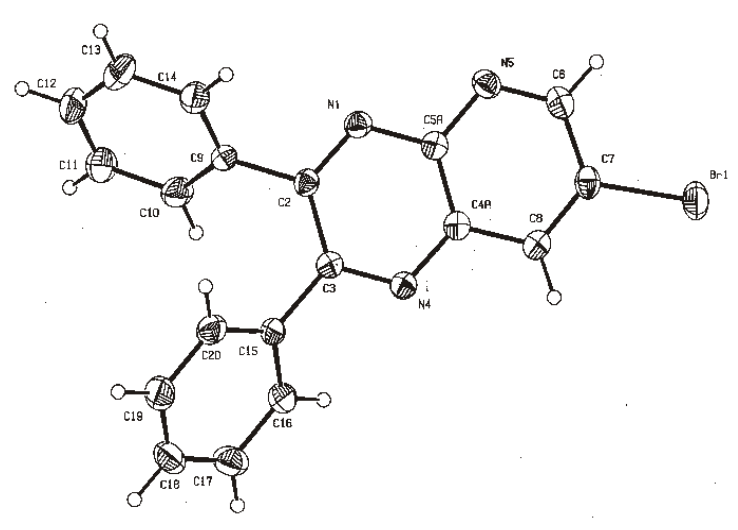
Zone of inhibition (mm)